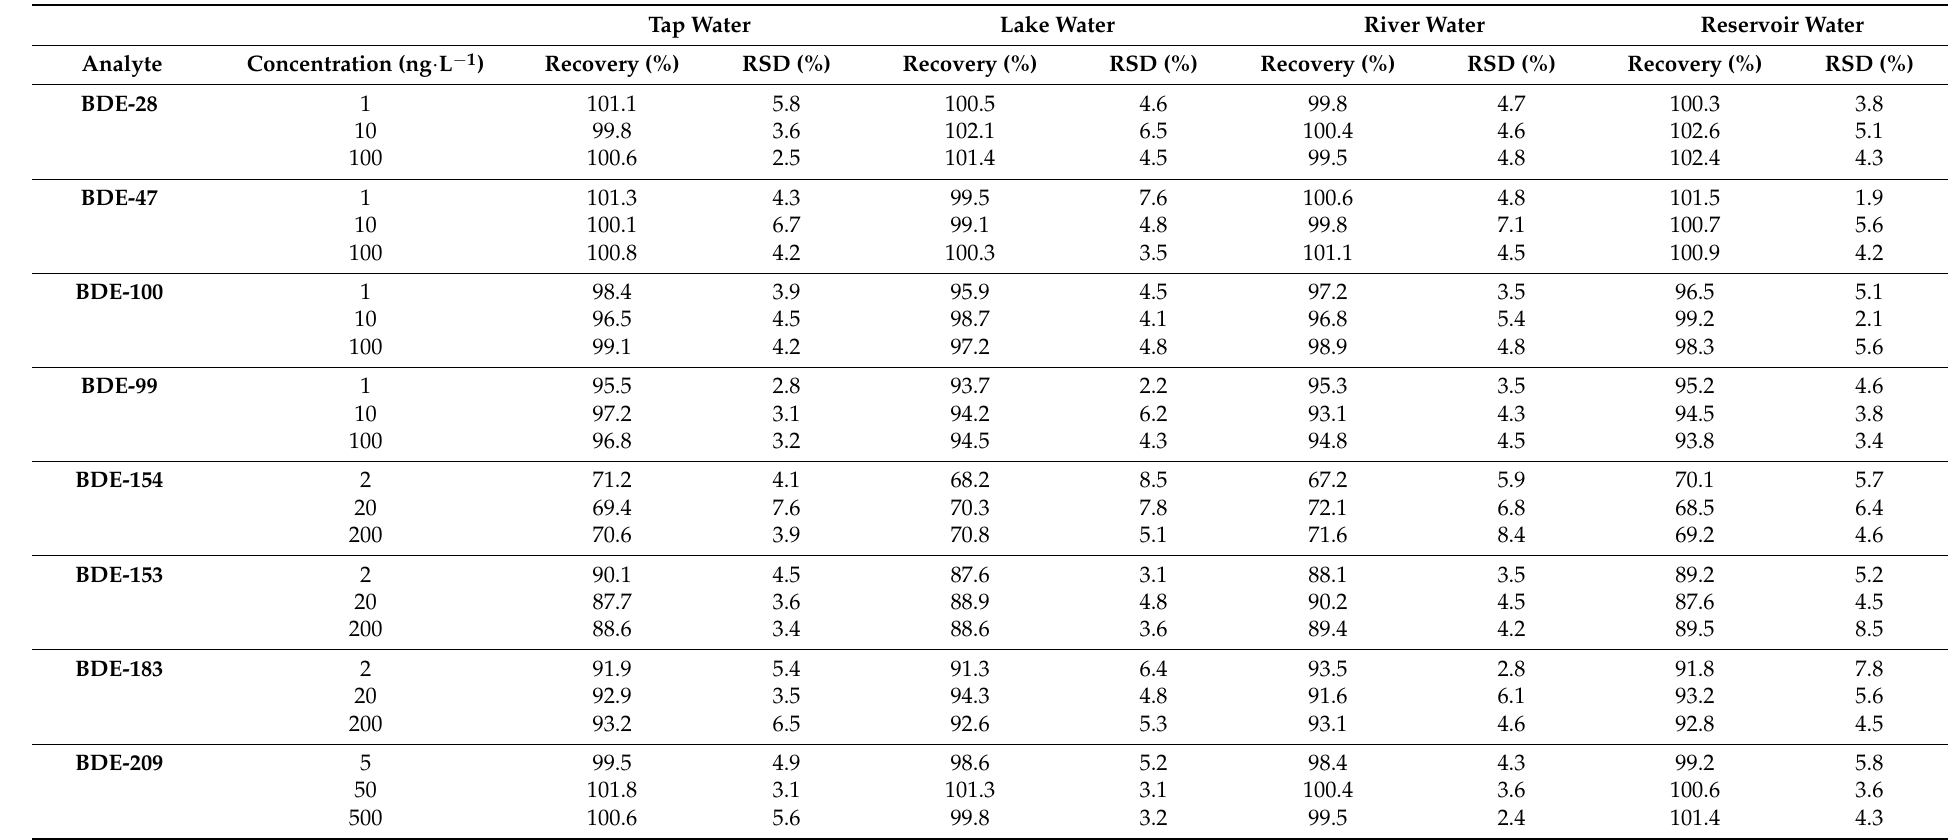
Table 2. Analysis of PBDEs in Water